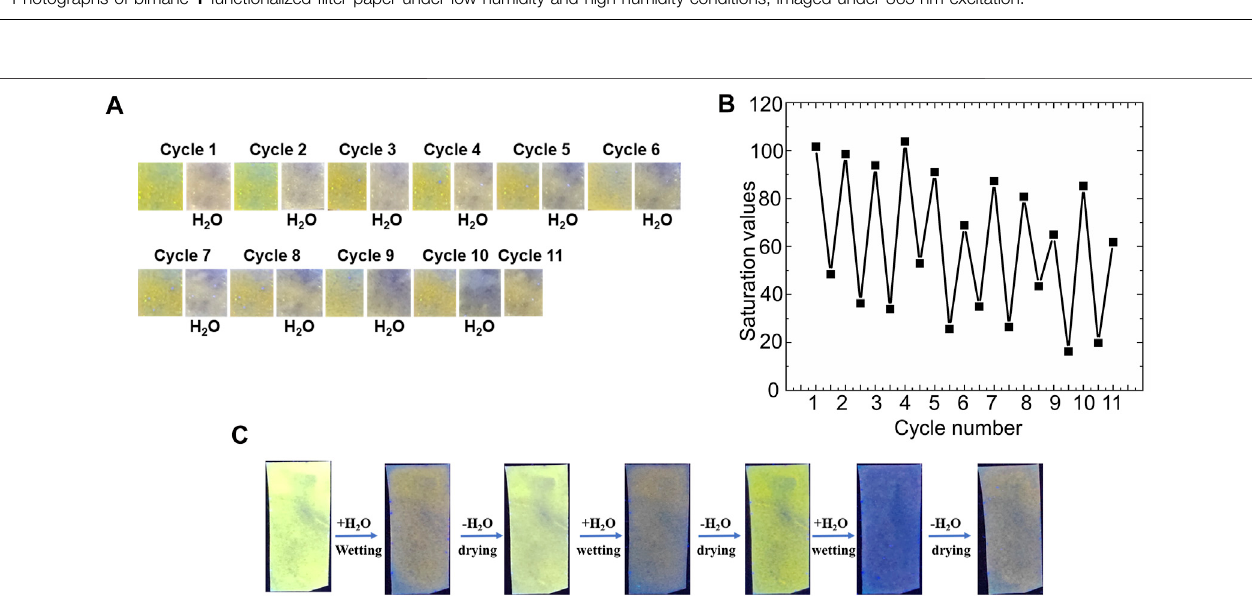
FIGURE 7 | An illustration of the regeneration and reusability of bimane 1 -functionalized fi lter papers: (A) The detection of liquid water droplets over 11 cycles of exposure followed by drying; (B) Quantitative green values of the papers plotted as a function of cycle number, with each cycle representing an exposure to water followedbydrying; and (C) Reusabilityofthepapersensorsforthedetection ofhumiditythroughexposingthepapers to99%relativehumidity,followedbydryingunder ambient humidity conditions and re-exposure.